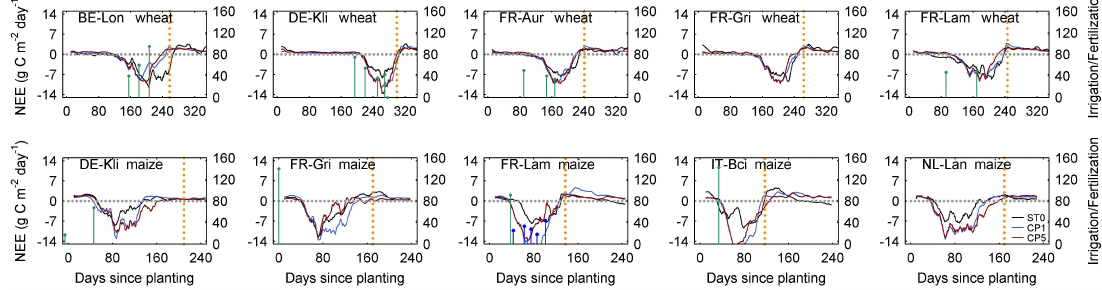
Figure 7. Temporal changes of daily net ecosystem exchanges (NEE) derived from observations (black line) and ORCHIDEE-CROP (ORC- CP1, blue line; ORC-CP5, brown line) since planting. The green and blue stems represent the fertilization (kgNha − 1 ) and irrigation (mm) events during the selected growing season. The dotted orange line indicates the harvest date since planting. The upper and lower panel shows the results for different sites of winter wheat and maize, respectively.